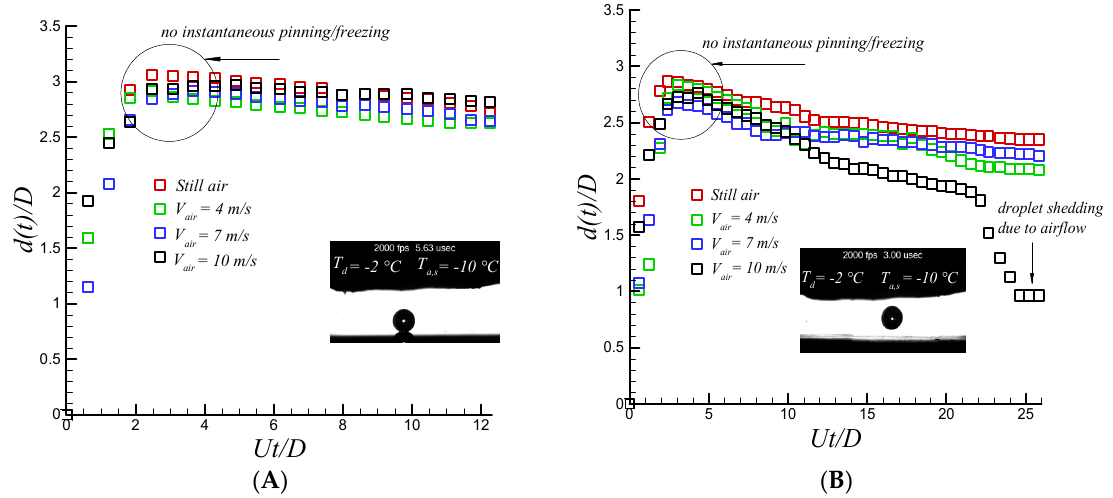
Figure 3. Temporal evolution of impacting supercooled water drop on aluminum ( A ) and Teflon substrate ( B ) exposed to cold air flow. Droplet size and impact velocity are 2.6 mm and 1.6 m/s, respectively.